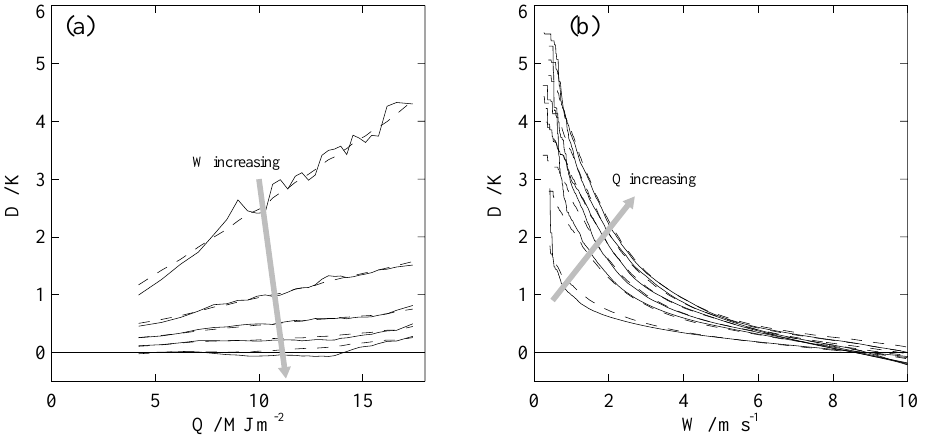
Fig. 6. Model plus background noise (dashed lines) compared with observations (solid lines), for 14:00LT. (a) Warming D as a function of integrated heat flux Q for various maximum 6-hourly wind speeds W ; W ranges from 1 to 10ms − 1 (in steps of 2ms − 1 ) . (b) Warming D as a function of maximum 6-hourly wind speed W for various values of the integrated heat flux Q ; Q ranges from 4.2 to 15MJm − 2 (in unequal steps).